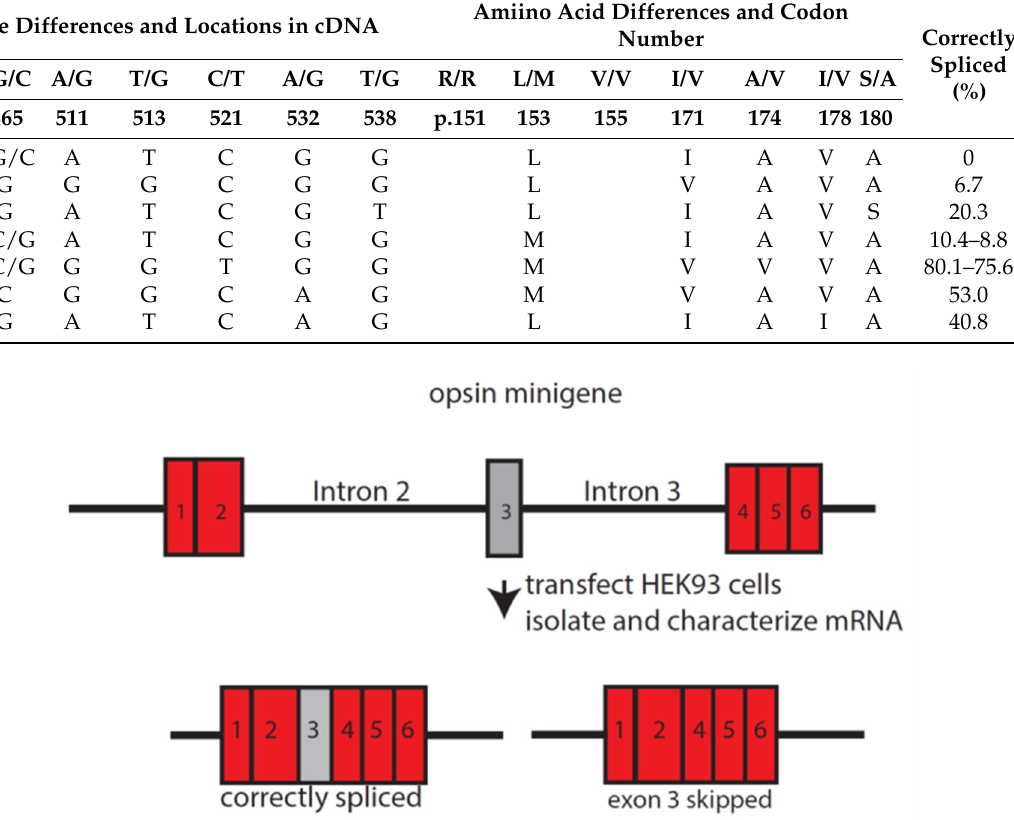
Table 2. Exon 3-skipping haplotypes associated with vision disorders.